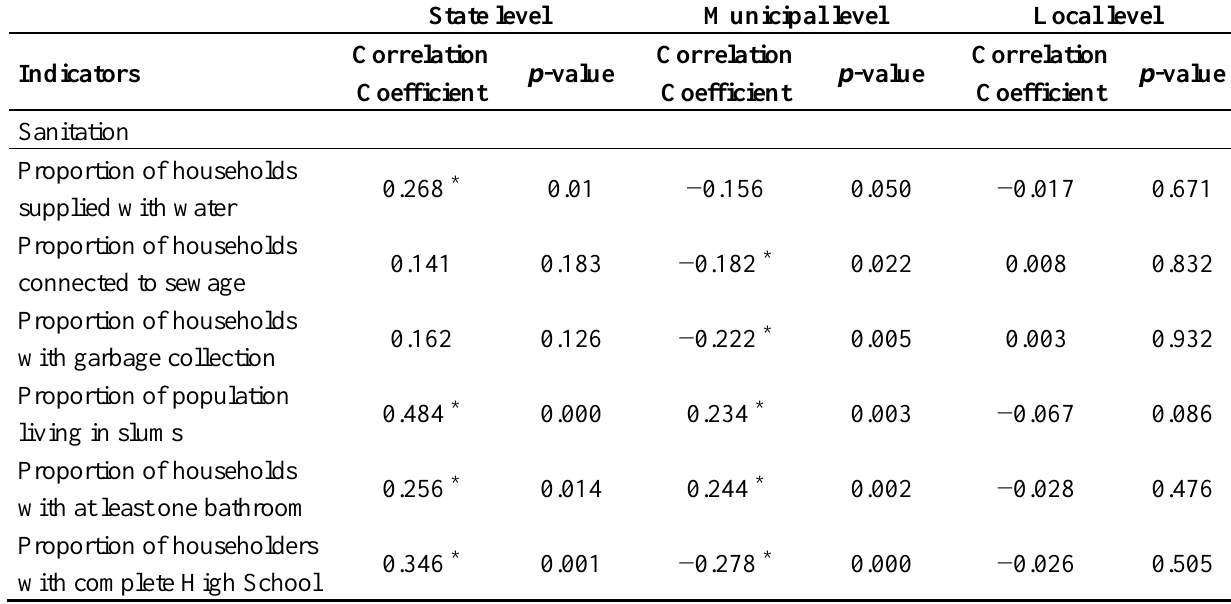
Table 3. Results of non-parametric Spearman’s rank correlation tests within the endemic period (1997–1998) at the three geographical